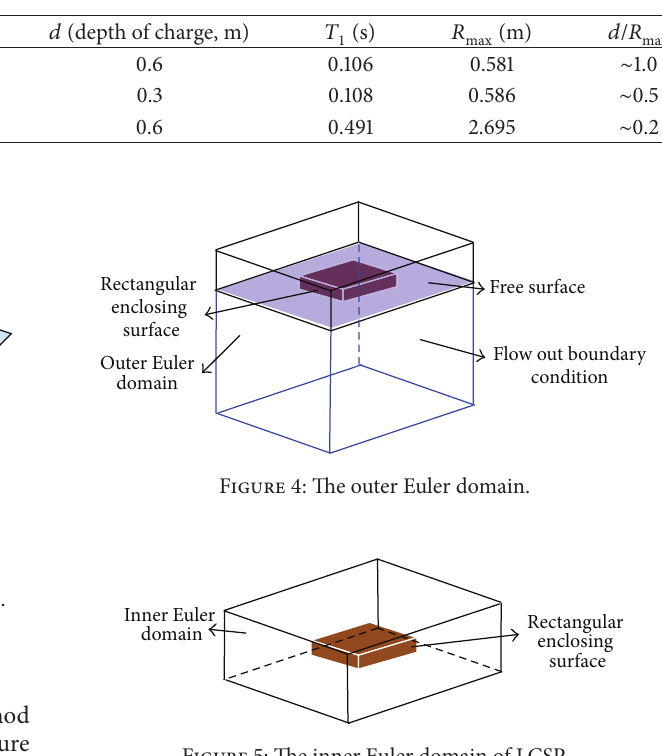
Figure 2: Schematic diagram of a lightweight corrugated sandwich plate (LCSP). Table 1: Various computational cases considered.